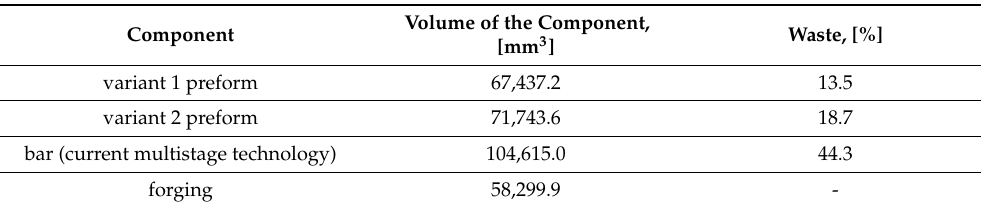
Table 3. Summary of the volume of geometry for each forging variant and the percentage of process waste for each technology.